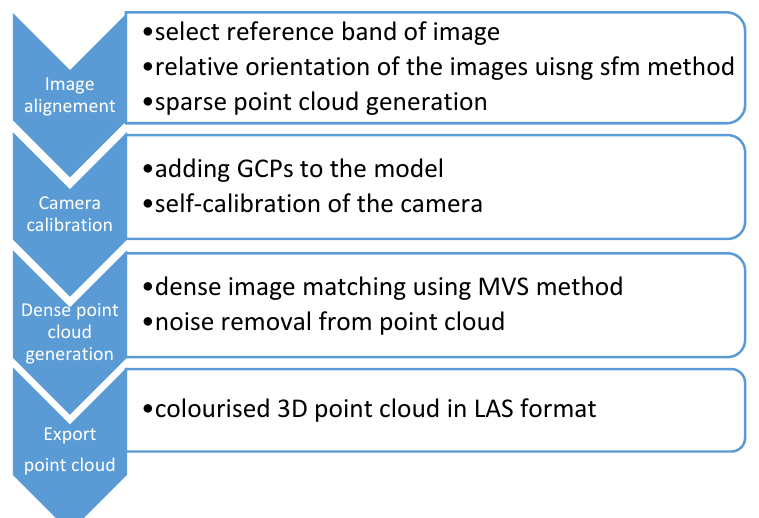
Figure 6. Workflow of photogrammetric data processing (from image to point cloud).